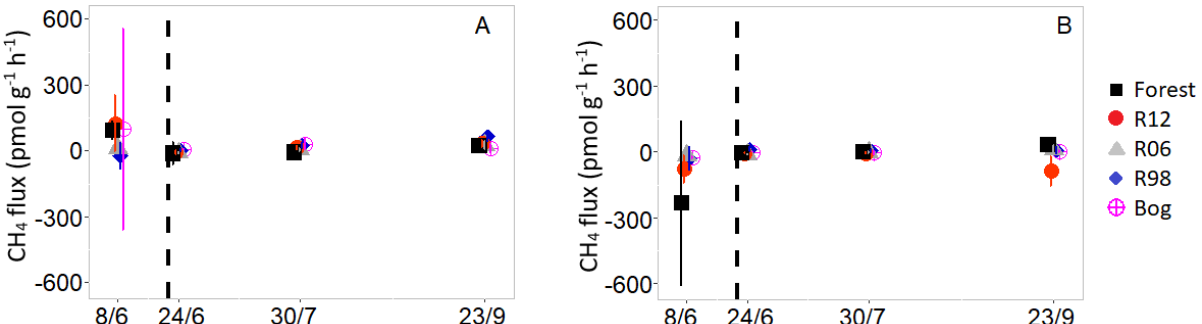
Figure 3. Methane (CH ) fluxes for the changed water level over the running time of the experiment (n=5). 4 Error bars are standard errors. Dotted vertical line is timing of water table change (from low to high). A) Shallow cores, B) Deep cores.